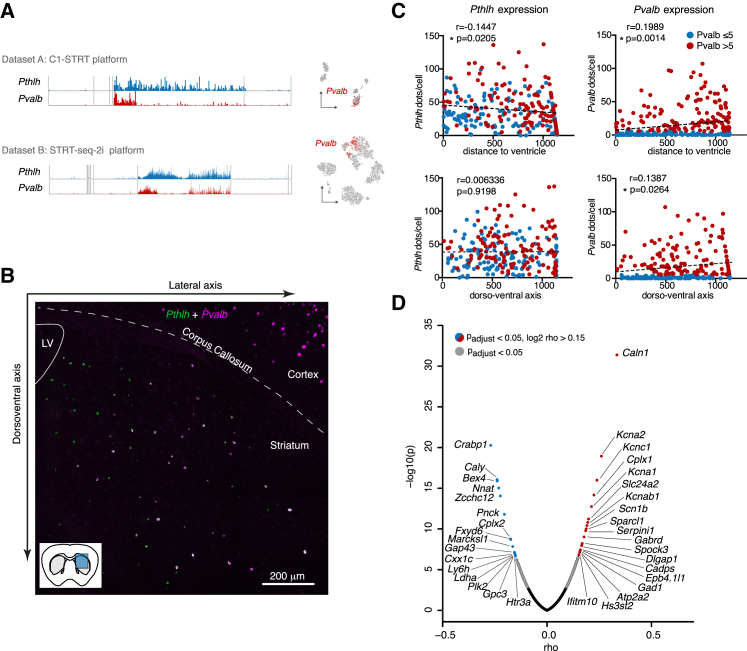
The Pthlh Population: Pvalb Co-expressing Cells and Spatial Organization(A) Molecular counts of Pthlh and Pvalb in each cell from BackSPIN analysis in both datasets, along with Pvalb expression labeled in red on tSNE plots.(B) Representative in situ hybridization showing the distribution in the dorsoventral and mediolateral axis of Pthlh and Pvalb expression.(C) Correlation of Pthlh and Pvalb expression with mediolateral or dorsoventral axis cell position. r and p values were acquired using Pearson’s correlation.(D) Volcano plot of genes with anti-correlation (blue) or correlation (red) to Pvalb. The y axis represents the log10 adjusted p value, and the x axis shows the rho value, both acquired using Spearman’s rank correlation coefficient.See also Figure S3 and Table S2.